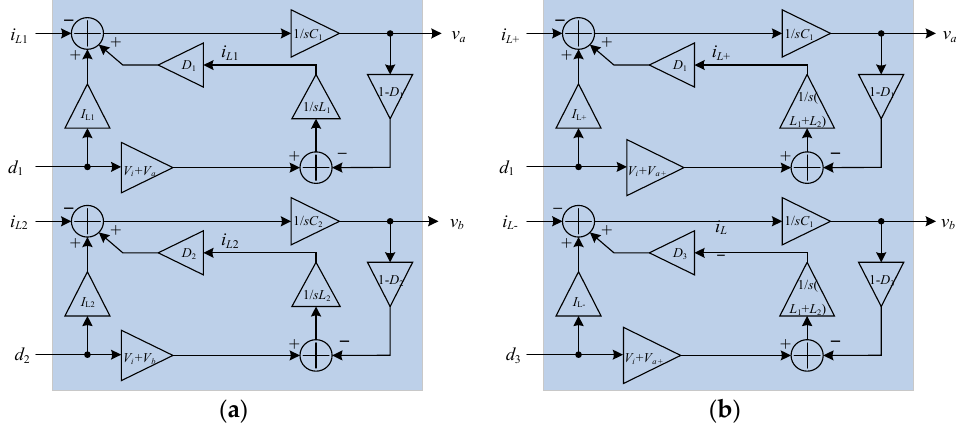
Figure 9. Small-signal model. ( a ) Small-signal model in DC mode ( b ) Small-signal model in AC mode. After obtaining the transfer function of the equivalent circuit, the equivalent small- signal block diagram of the converter can be determined, as shown in Figure 10. Herein, G ( s ) is the transfer function between duty cycle D ( s ) and output I o ( s ), and E ( s ) is the error transfer function between I o ( s ) and I g . G m ( s ) is the transfer function of the PWM generator, H ( s ) is the transfer function of the sampling, and G vd ( S ) is the transfer function of the